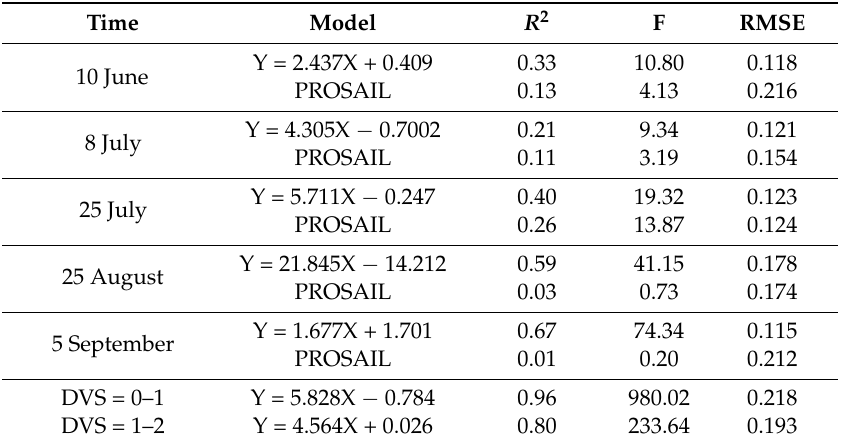
Table 7. Analysis results of PROSAIL and regression methods for LAI